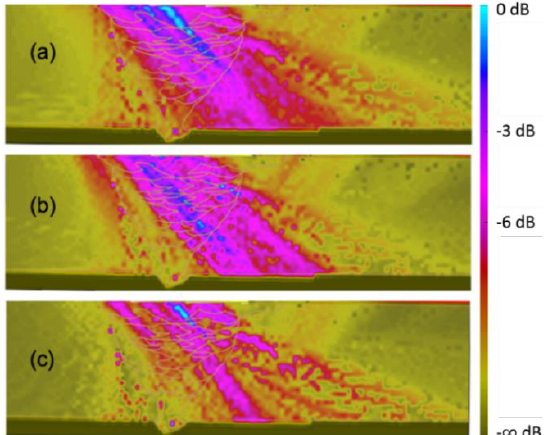
Figure 8. Longitudinal wave inspection. Scanning angle of 48°, index 22 mm. Number of ( a ) 16, ( b ) 24 and ( c ) 32. elements: ( a ) 16, ( b ) 24 and ( c ) 32.